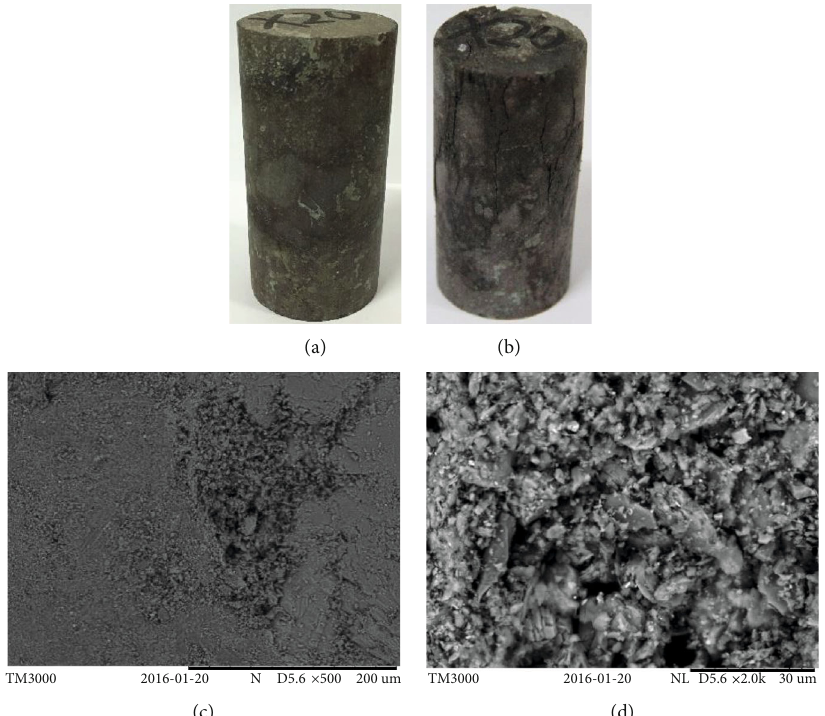
Figure 3: Characterization of amygdaloidal basalt sample: (a) specimen before the test; (b) specimen after macroscopic failure; (c) microstructure of the amygdaloidal basalt sample in SEM: magni fi ed 200 times; (d) microstructure of the amygdaloidal basalt sample in SEM: magni fi ed 2000 times.